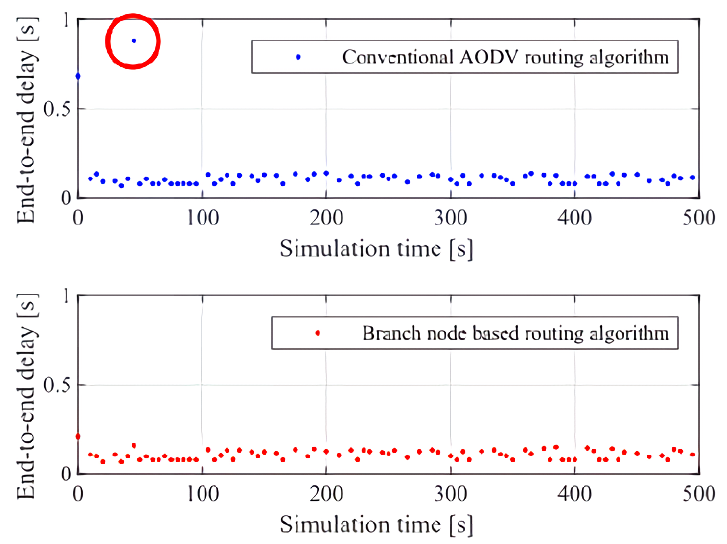
Figure 17. Performance comparison of end-to-end